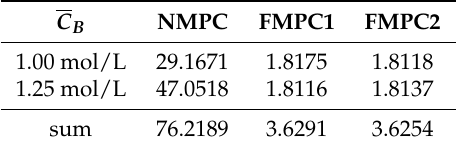
Table 1. Average duration of action of the algorithms in the experiments depicted in Figure 3. C